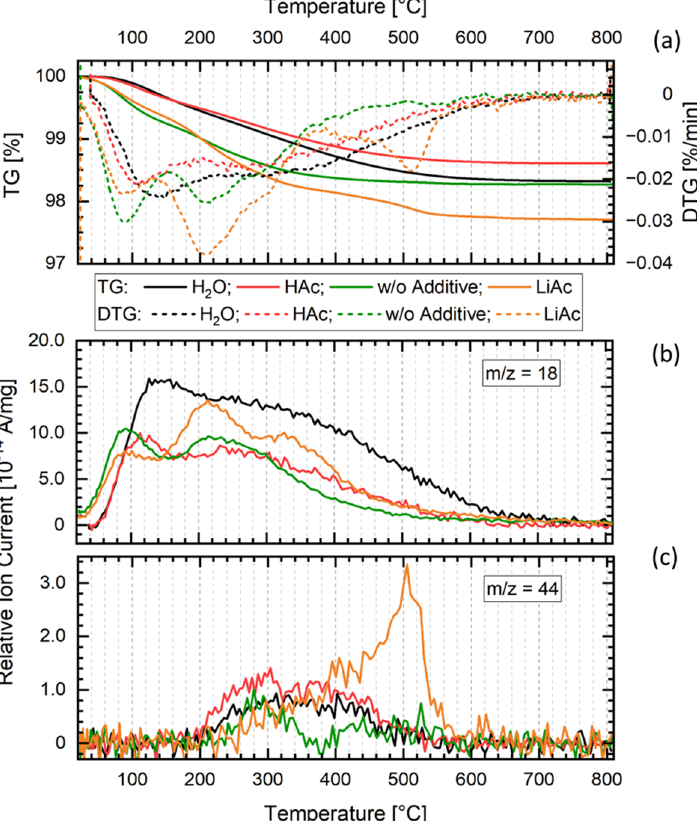
Figure 6. Thermogravimetry ( a ) with emission gas mass spectroscopy ( b , c ) (TGA–MS) of cold-sintered samples without additive and with H 2 O, Hac, and LiAc additives. m / z = 18 corresponds to water vapor and m / z = 44 to CO 2 .